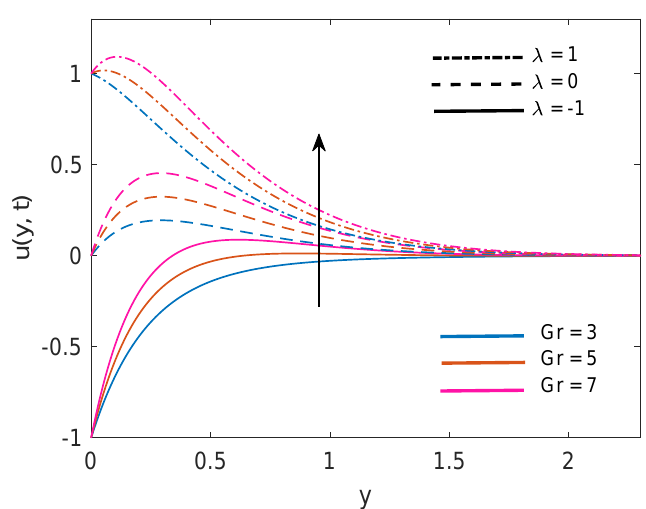
Figure 4. Variation in velocity profile for different Gr when Nr = 1.5, K = 5, Q = 0.5, M 2 = 5, φ = 0.1 and t = 0.5.